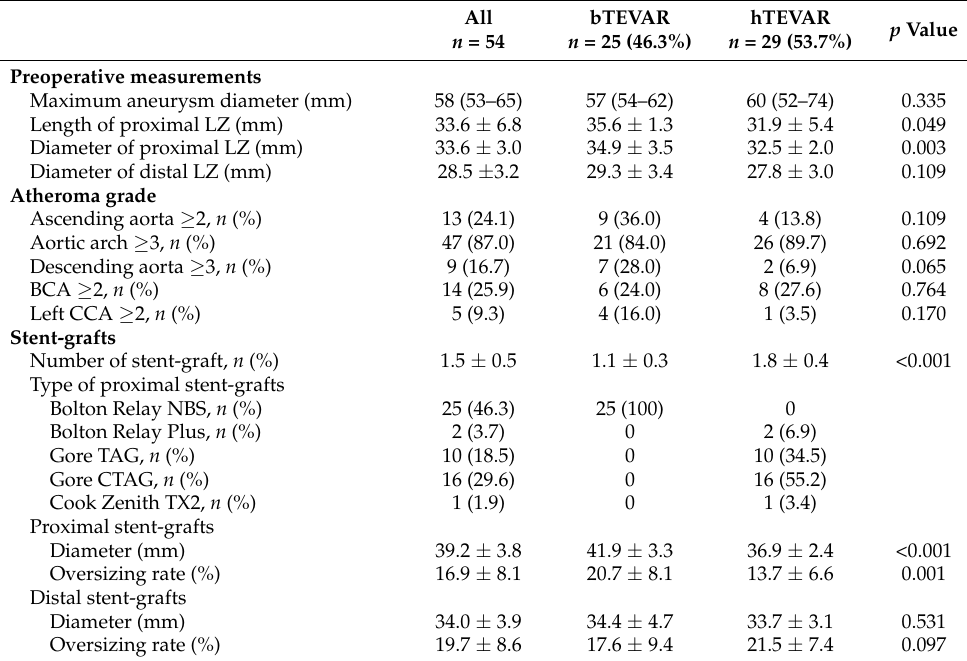
Table 2. Preoperative measurements and